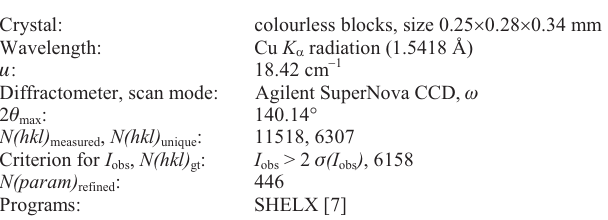
Table 1. Data collection and